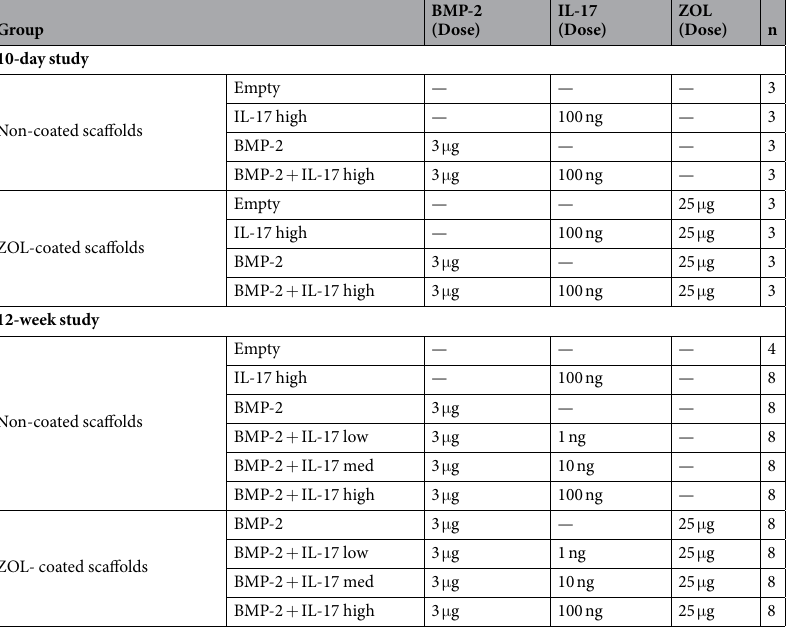
Table 1. Composition of the constructs for the in vivo assessment of 10-day tissue response and 12-week bone formation. BMP-2, bone morphogenetic protein 2; IL-17, interleukin 17; ZOL, zoledronic